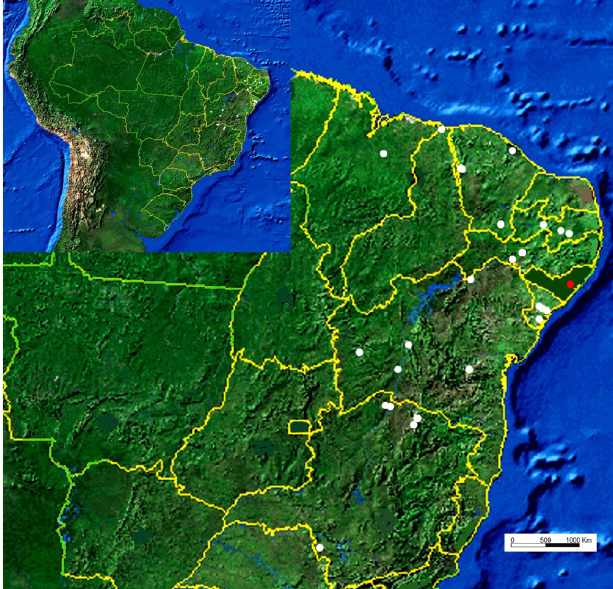
Figure 2. Distribution map of indicated by a red